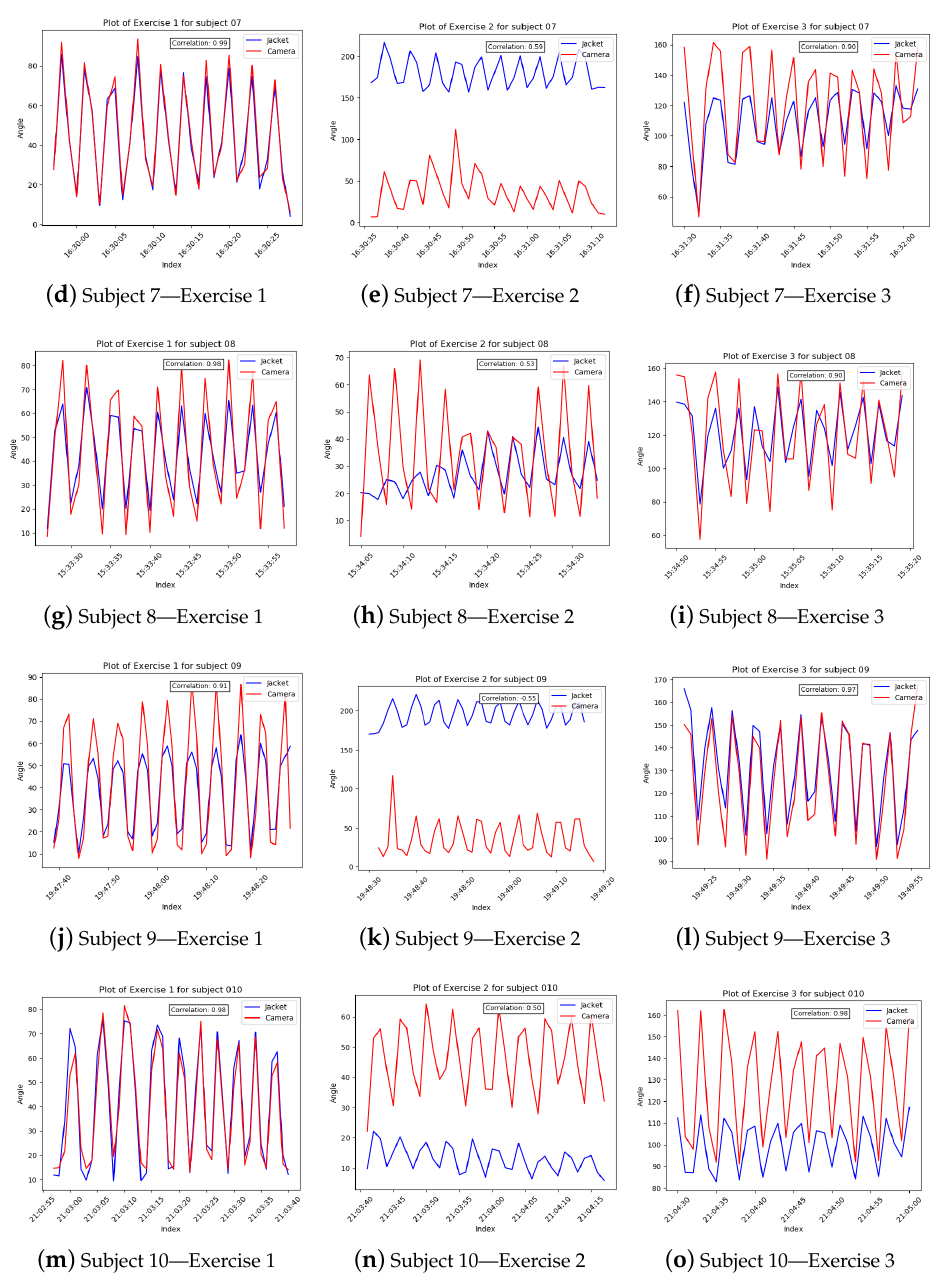
Figure 5. Robotic jacket validation experiment results for subjects 6 through 10. The camera angle measurements (red) are overlaid with the wearable jacket-generated inertial sensor approximation (blue) over